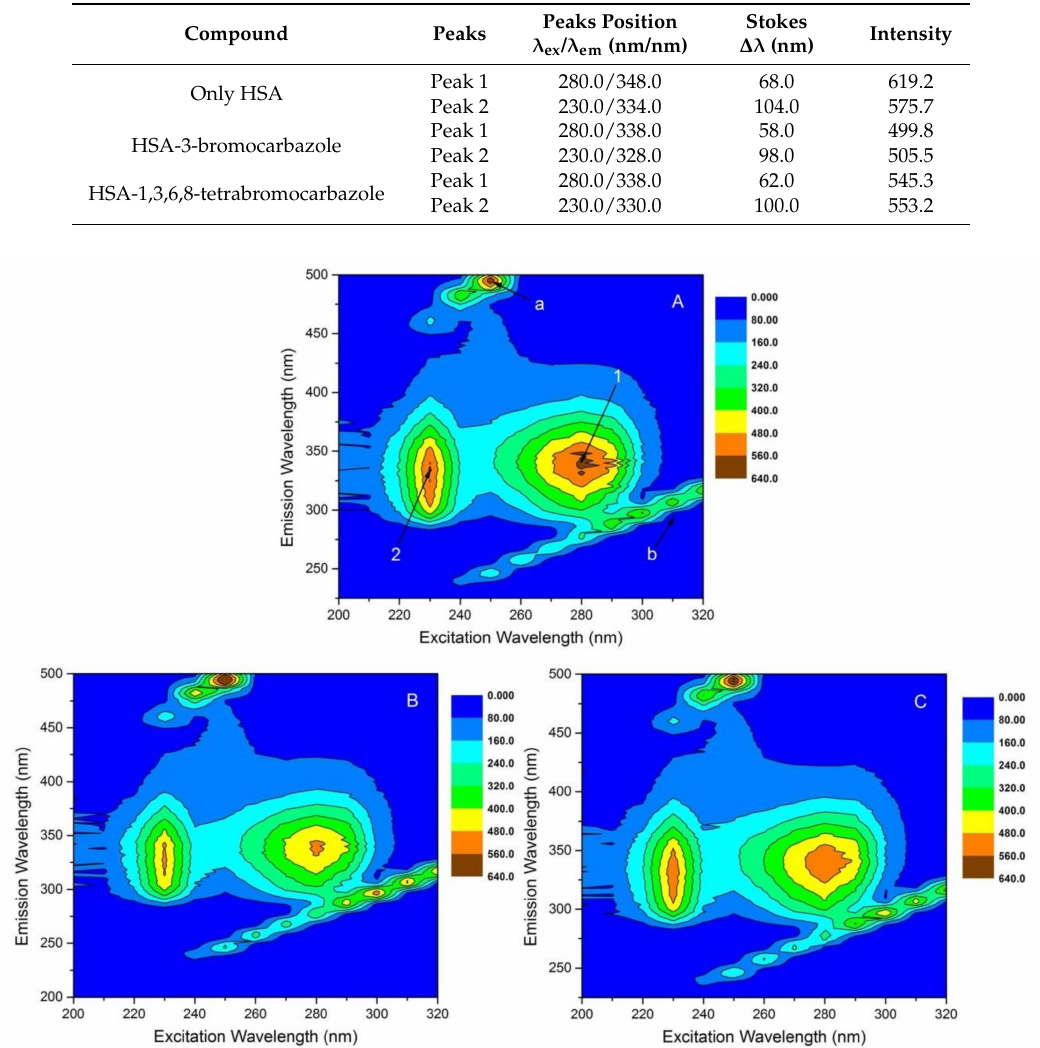
Figure 7. 3D fluorescence spectra of HSA in the absence and presence of 1,3,6,8-tetrabromocarbazole or 3-bromocarbazole at 298 K. C HSA = 2 × 10 − 6 M; ( A ): Only HSA, 1:0; ( B ): HSA-3-bromocarbazole, 1:1; ( C ): HSA-1,3,6,8-tetrabromocarbazole,